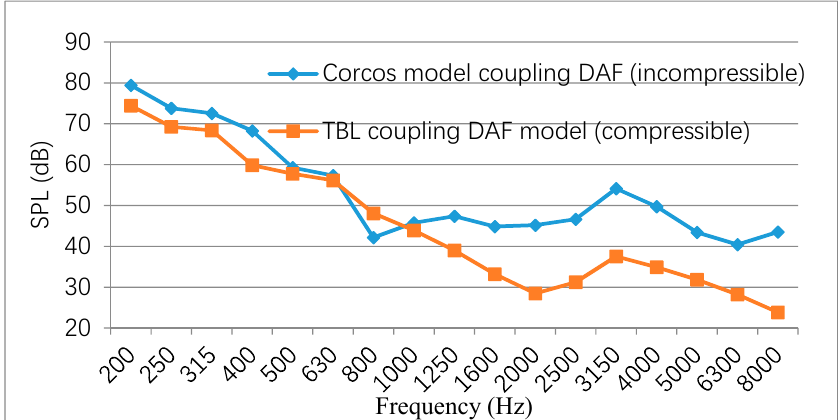
Figure 25. Comparison of the results of Corcos model coupling DAF under the incompressible numerical simulation and TBL coupling DAF model of WFS under the compressible numerical simulation.